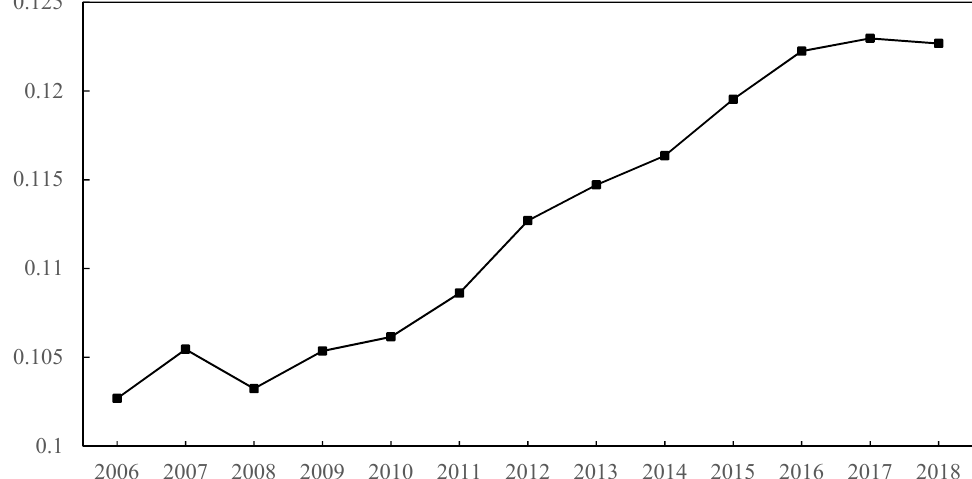
Figure 2. Change of average pleasantness of policy environmental in Central China. Note: Built by the authors based on the data calculated through abovementioned method.